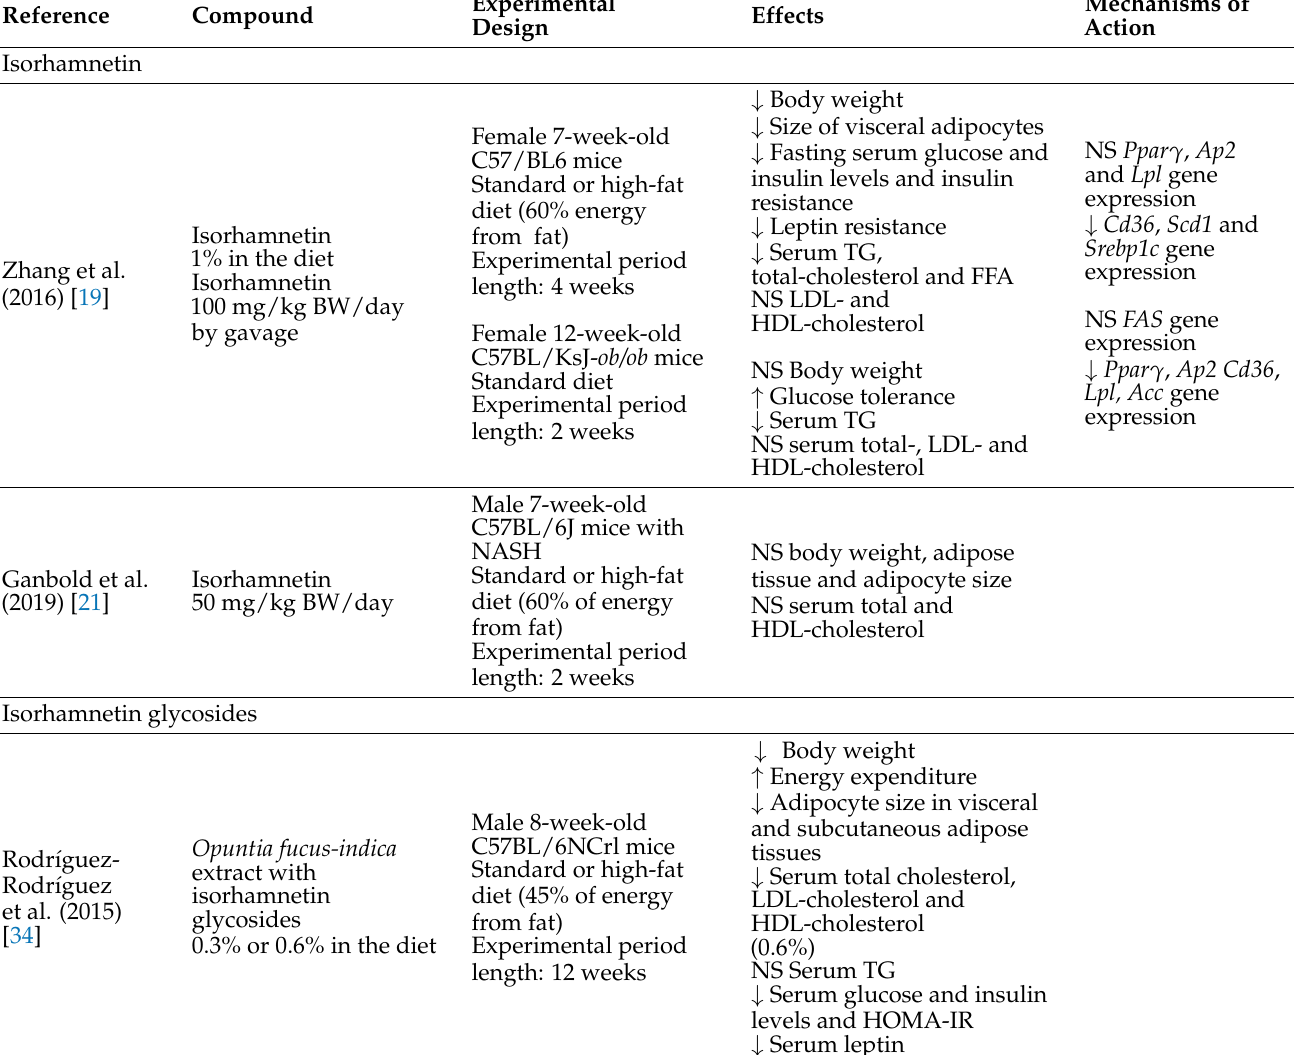
Table 3. Effects of isorhamnetin on body weight, adipose tissue and serum parameters in